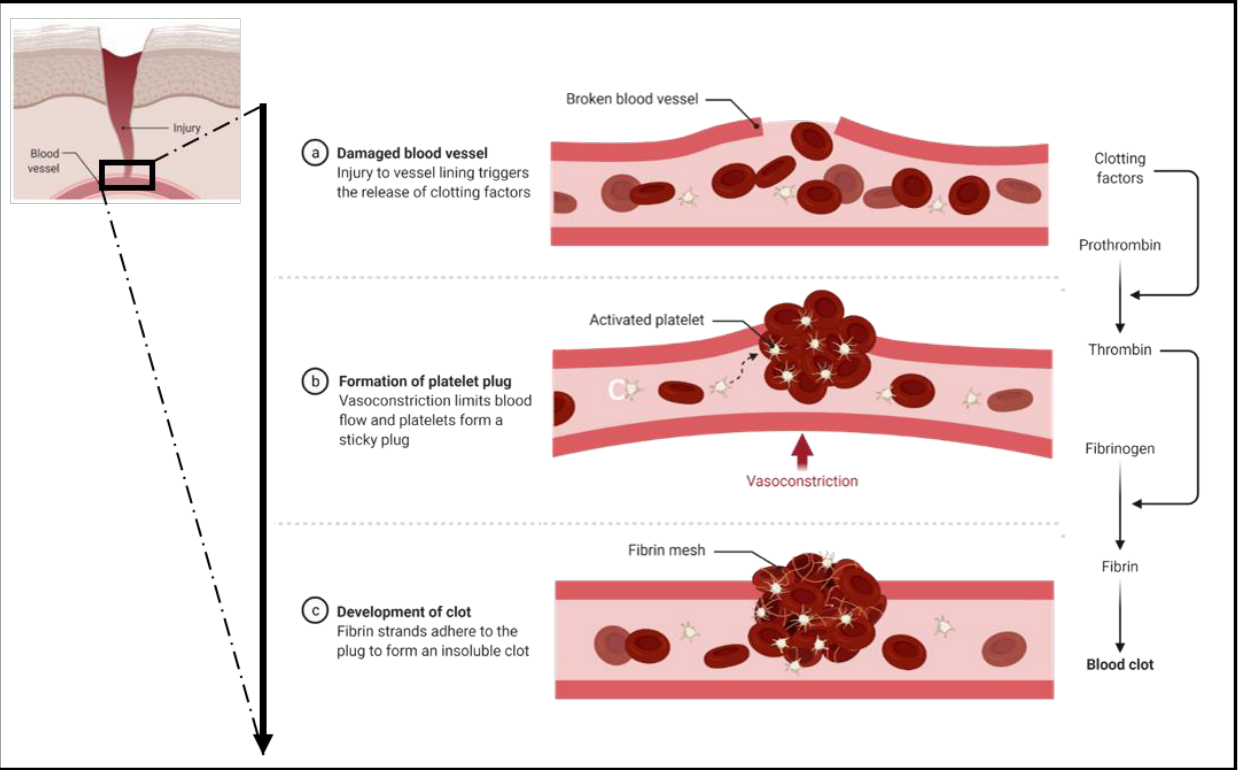
Figure 3. Simplified scheme of blood coagulation upon vessel injury. Created with biorender.com (accessed on 1 February 2022).